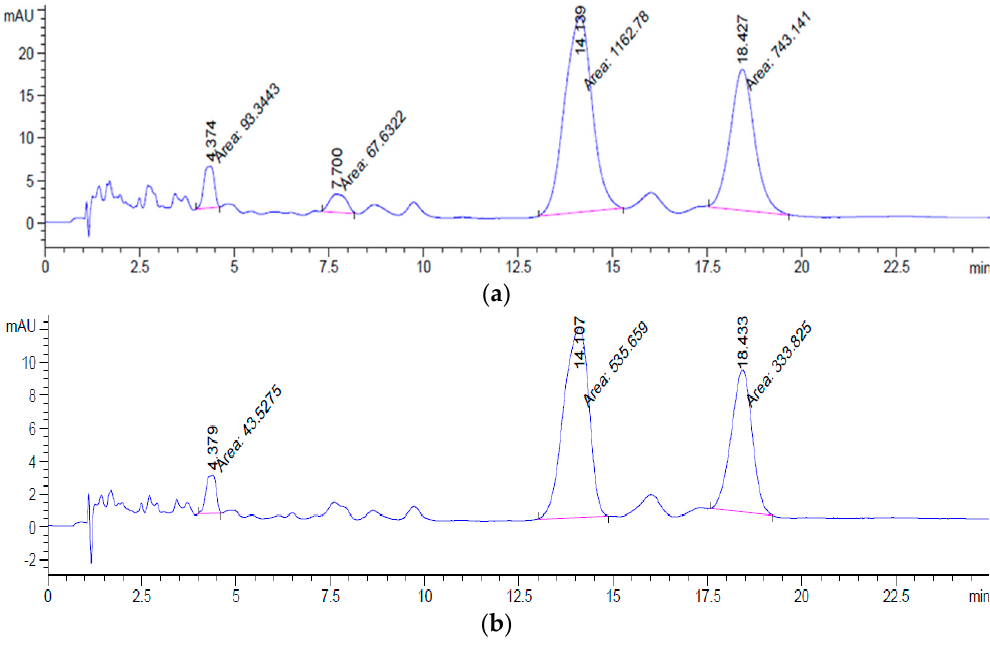
Figure 9. The HPLC spectrum (a) gac-oil and (b) SLNs-gac oil.